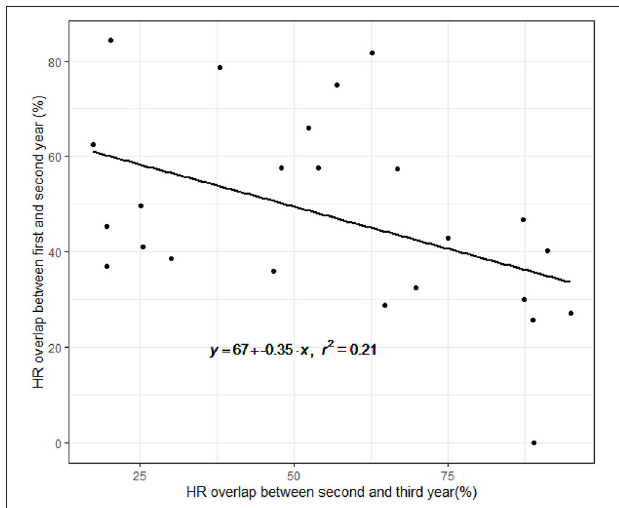
FIGURE 2 | Correlation between home range overlap during the first and second year, and the home range overlap between the second and third year. The black line is the expected linear relationship. The negative relationship indicates that individuals that shifted little between the first and second year, exhibited larger shifts between the second and third